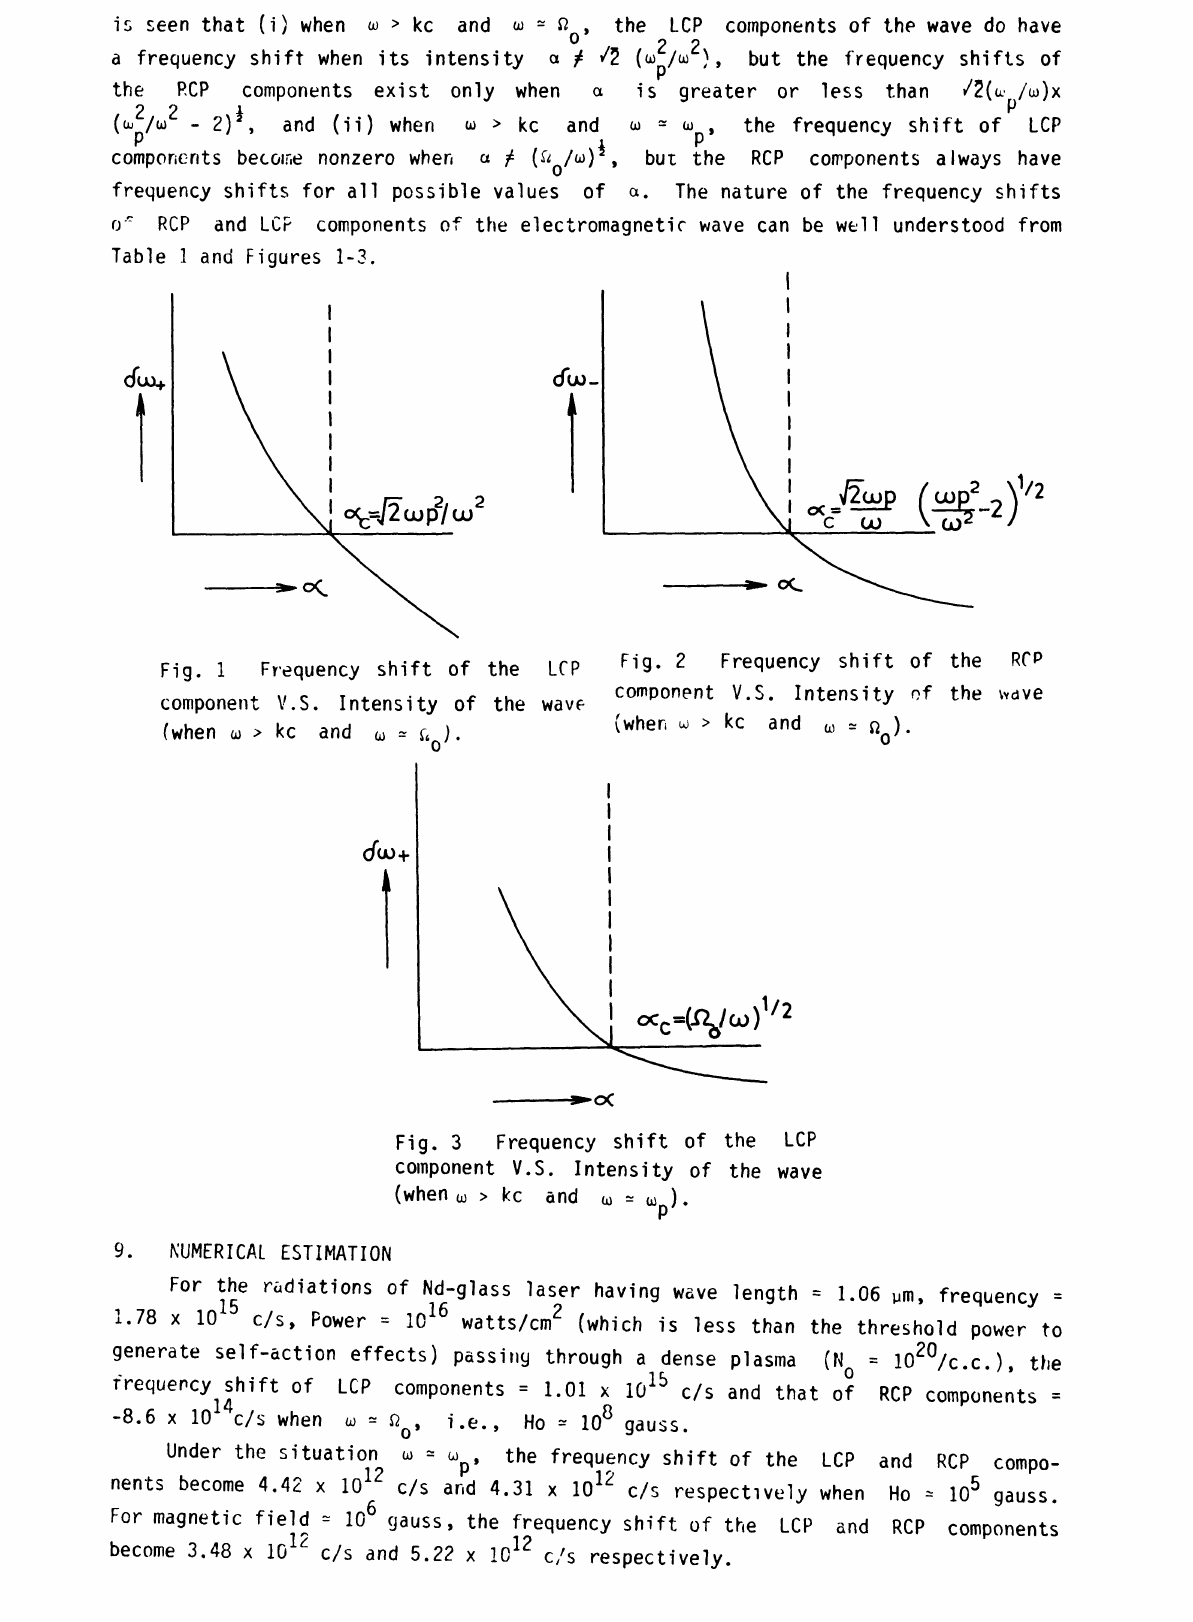
2 Frequency shift of the RCP component V.S. Intensity ef the Yve component V.S.